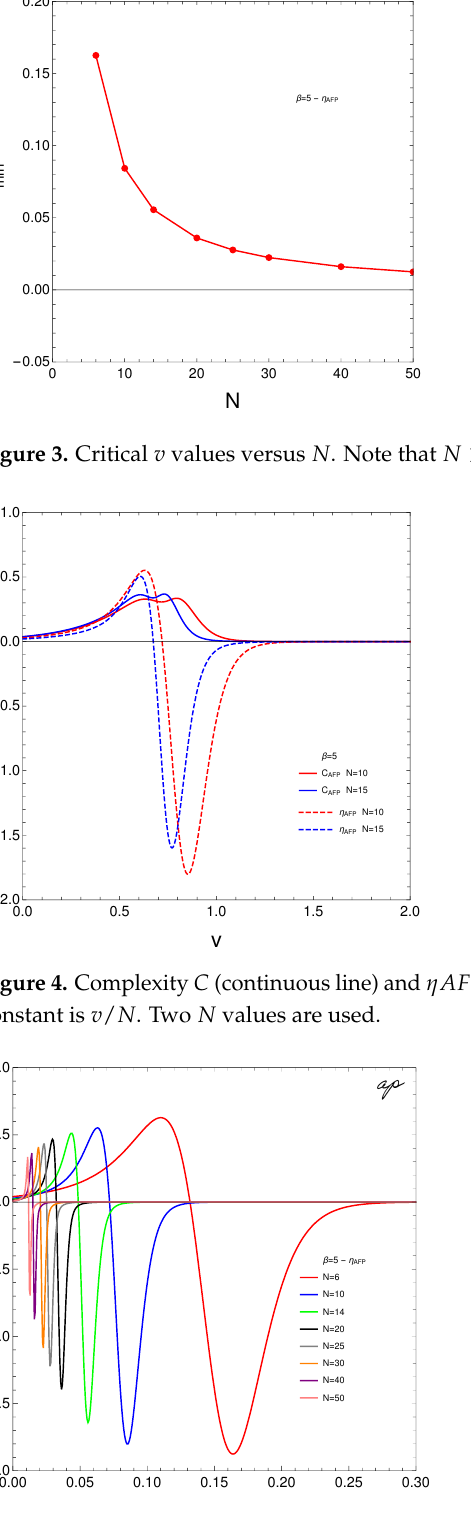
Figure 5. η AFP plotted versus v . The effective coupling constant is v / N . Eight different N values are used. A different color is assigned to each value, as indicated in the